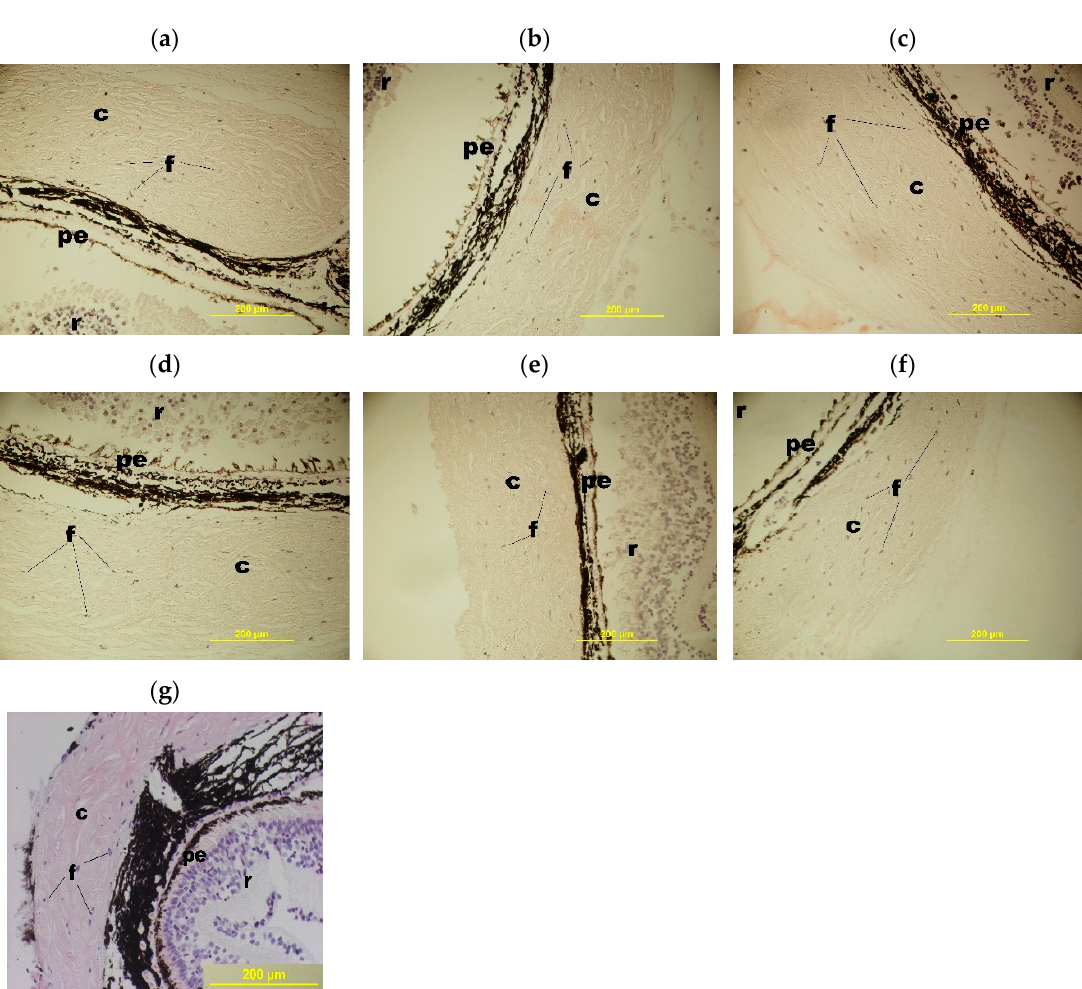
Figure 5. Histological micrographs of the cross-sections of the posterior part of the newt Pl. waltl eye after their 72-h-long organotypic cultivation. The samples were taken from the following reference and experimental Groups: 1 ( a ), 2 ( b ), 3 ( c ), 4 ( d ), 5 ( e ) and 6 ( f ); image ( g ) is the histological micrograph of the cross-sections of the posterior part of the newt Pl. waltl eye before any incubation (abbreviations in the micrographs: c —cavity, f —fibroblasts, pe —pigmented epithelium, r —retina). (iii) Reference samples from Group 3 (Figure